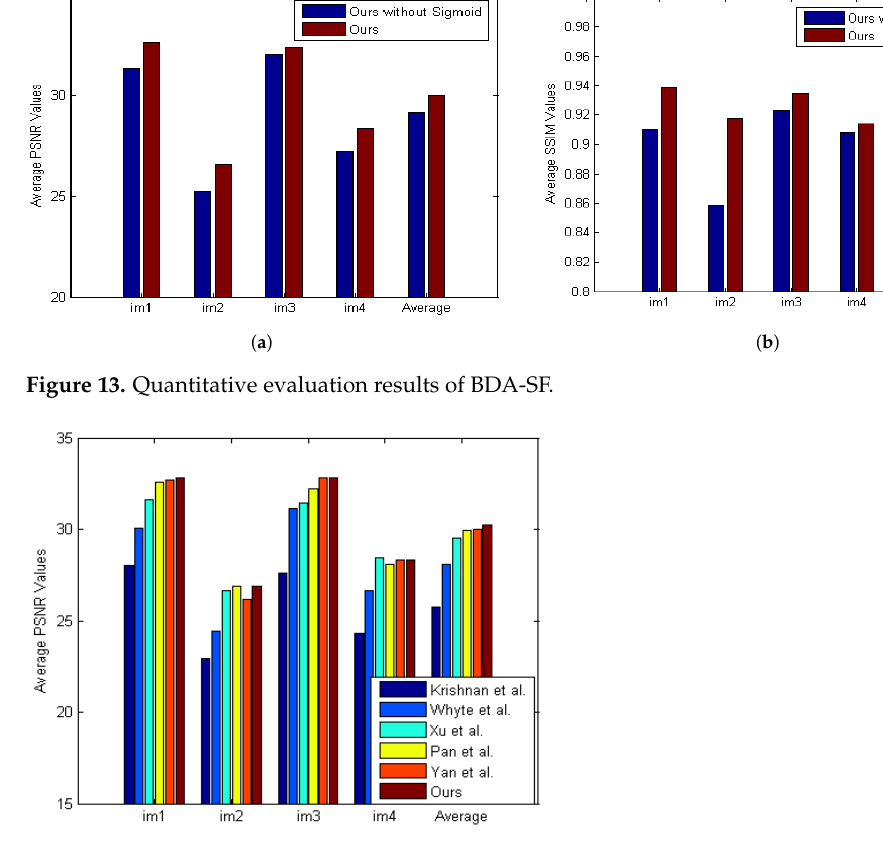
Figure 14. Quantitative evaluation results on the dataset [57].